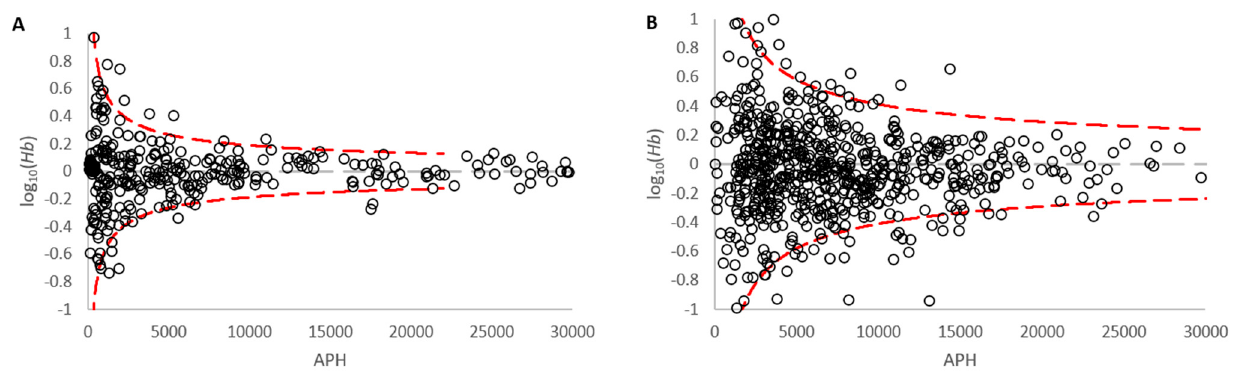
Figure 5. DSCS peak height variability ( A ) Standard Analysis ( B ) DSCS. DSCS results in a broader distribution due to the increased variance/peak height imbalance due to low template effects.